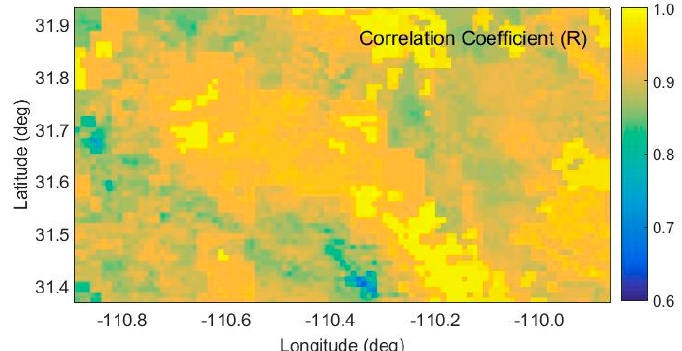
Figure 5. Spatial correlation coefficients between derived subsurface soil moisture and MOD-SMET ET values over the entire study domain for year 2013.